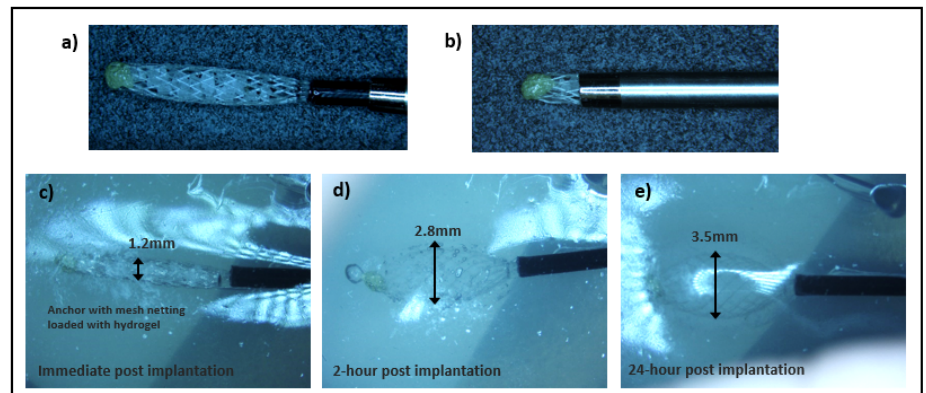
Figure 2. Hydrogel-anchored microdevice. The anchor consists of hydrogel water-absorbable particles contained within bioabsorbable mesh netting ( a ), which in its collapsed form can be loaded into a 17G needle for percutaneous implantation ( b ). After deployment into phantom ( c ), the hydrogel gradually expands by absorbing water ( d ). Maximal expansion is noted by 24 h after deployment ( e